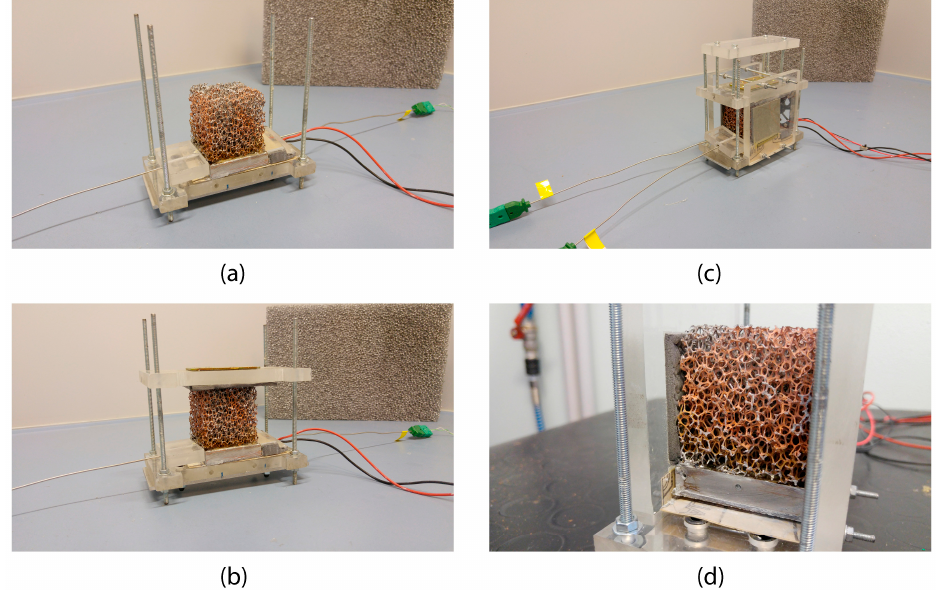
Figure 7. Phases of the assembly procedure; ( a ): First part of the assembly- Foam positioning; ( b ): Second part of the assembly-The upper part of the plexiglass house is positioned on the top of the foam; ( c ): Final phase of the assembly-The vent is positioned and the system is ready to be used; ( d ): A detail view of the foam insulating.